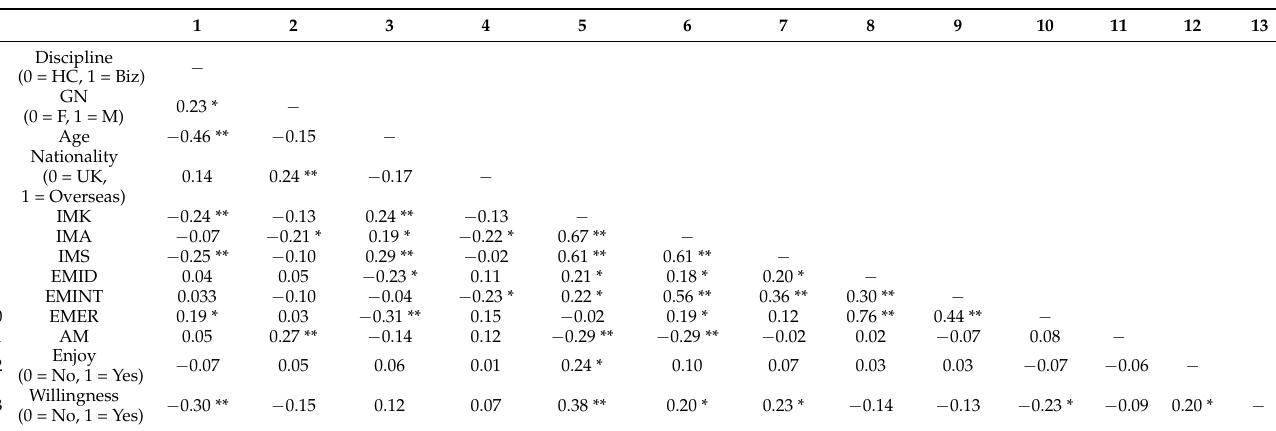
Table 5. Correlation between the discipline, gender, age, nationality, types of motivation, learning enjoyment, and willingness to study without reward among online students (n =